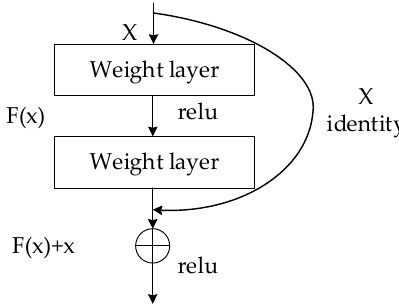
Figure 3. Residual learning: a building block.